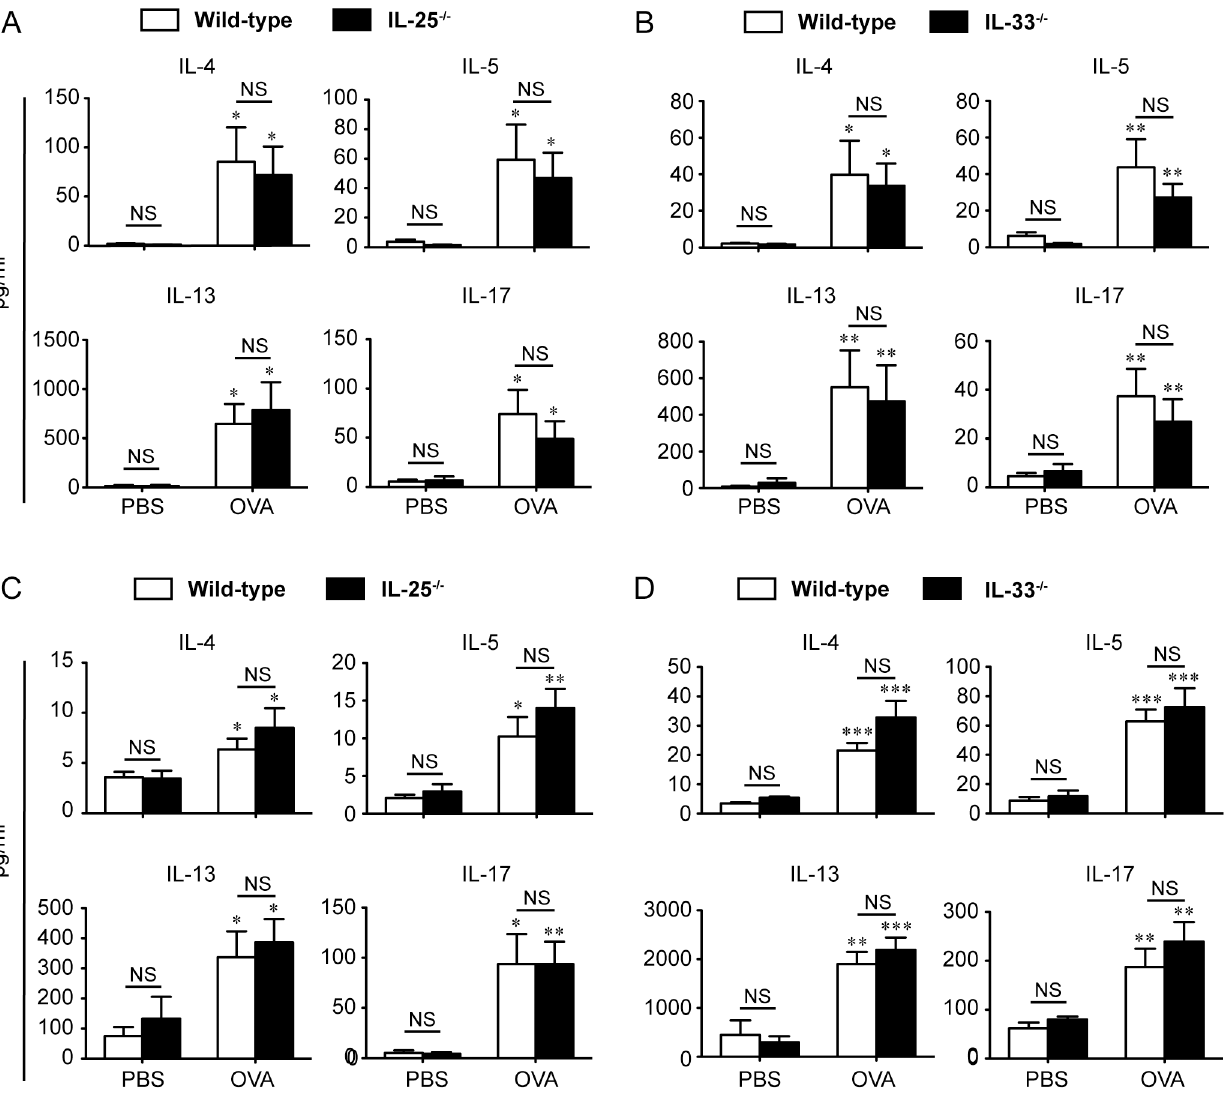
Fig 2. Normal Th2- and Th17-type cytokine production by DLN and spleen cells of IL-25 -/- and IL-33 -/- mice sensitized epicutaneously (EC) with OVA. DLN and spleens were collected from mice 24 hours after the last EC sensitization with OVA. DLN and spleen cells were cultured with OVA in PBS or PBS alone. ELISA was performed to determine the levels of IL-4, IL-5, IL-13 and IL-17 in the culture supernatants of the DLN cells from wild-type (WT) mice and IL-25 -/- mice (A) and from WT mice and IL-33 -/- mice (B), and the spleen cells from WT mice and IL-25 -/- mice (C) and from WT mice and IL-33 -/- mice (D). Data show the mean + SEM (n = 8 – 23). * P < 0.05, ** P < 0.01 and *** P < 0.001 vs. the corresponding values for the culture with PBS alone. NS means “ not significant ” between the indicated group (WT vs. IL-25 -/- , or WT vs. IL-33 -/-